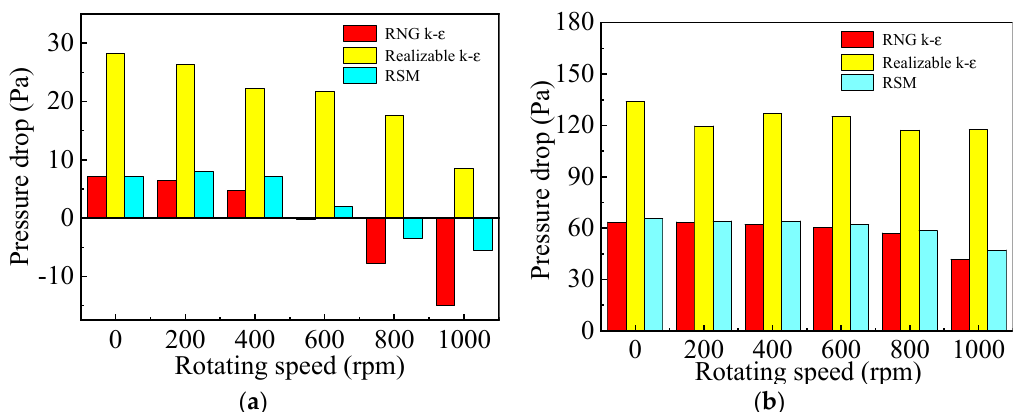
Figure 3. Comparison of the experimental total pressure drop with calculated pressure drop for three turbulence models at different gas flow rates and rotating speeds. ( a ) Gas flow rate of 200 m 3 ·h − 1 ; ( b ) gas flow rate of 800 m 3 ·h − 1 .